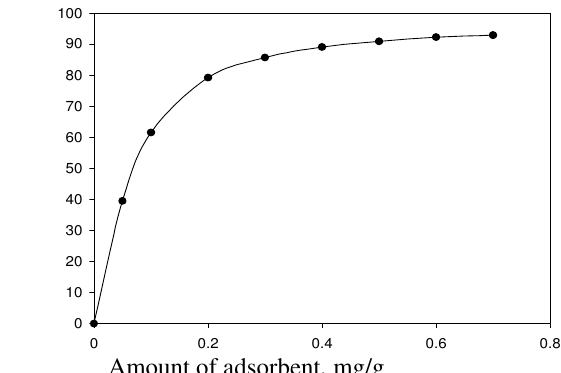
Amount of adsorbent, mg/g